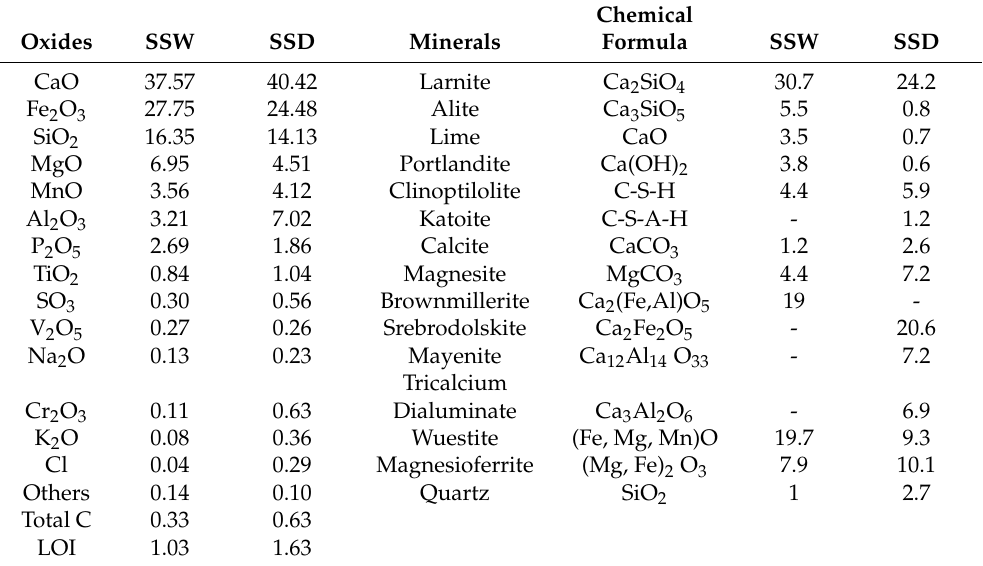
Table 1. The main oxides and minerals compositions of the steel slag powder (SSD) and steel slag mud (SSW)